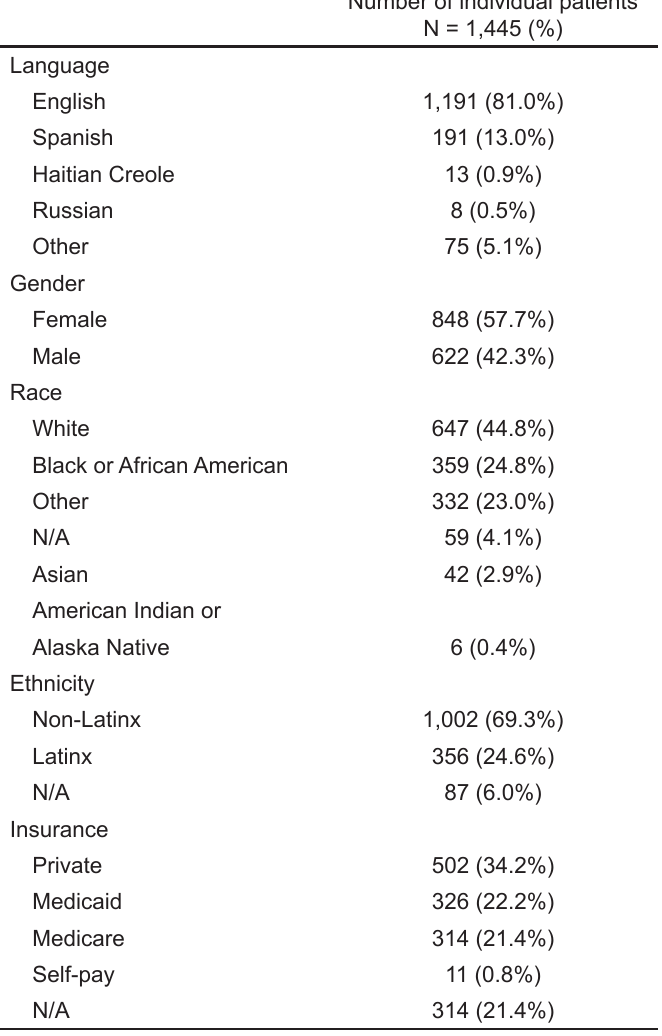
Table 2. Demographics of patients discharged from the emergency department with pending COVID-19